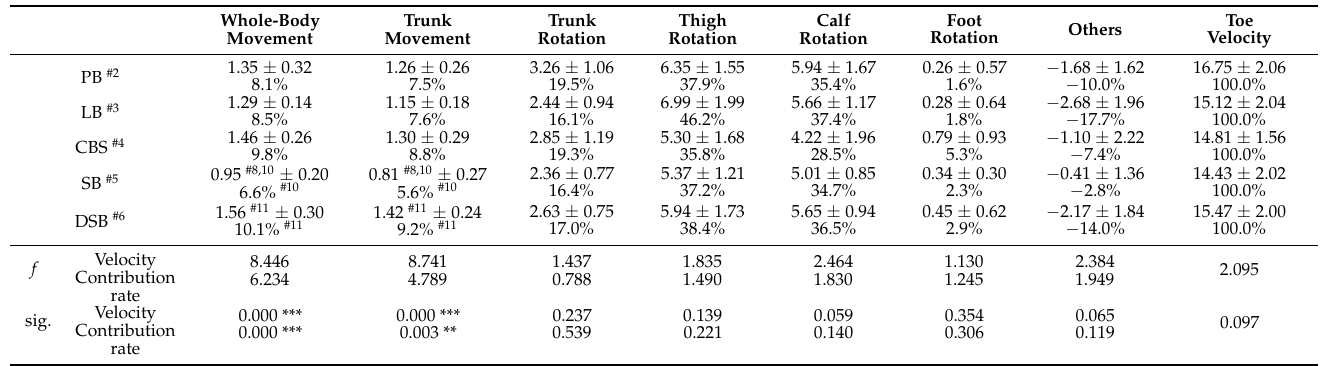
Table 4. The contributions of the roundhouse kick with distance-change types of footwork in impact event. Unit: